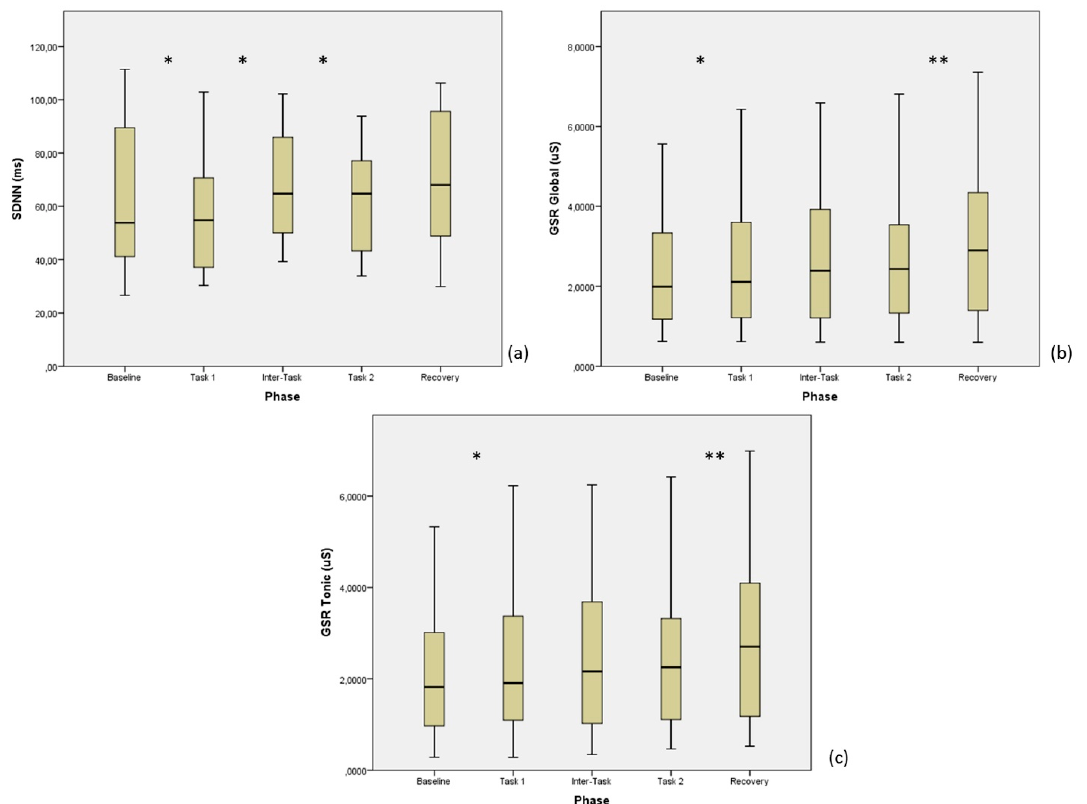
Figure 1. Autonomic parameters variation across the test phases for Group A: ( a ) SDNN; ( b ) global GSR; ( c ) tonic GSR (*: p < 0.05; **: p < 0.01).